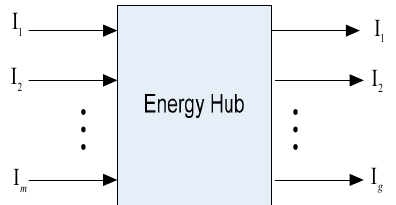
Figure 5. Energy carriers transformation through an EH.